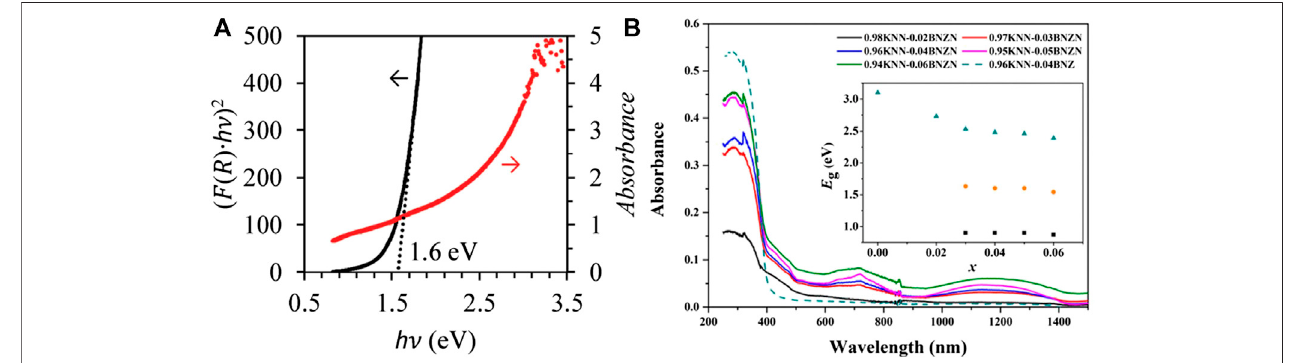
FIGURE 2| Absorbance and band gap determination of (A) 0.98KNN-0.02BNNO and (B) different compositionsof KNBNZNO. E g – band gap; h ] – photon energy; R – re fl ectance. Reproduced with permissions (Bai et al., 2017b; Zhong et al., 2019). Copyrights 2017 and 2019,